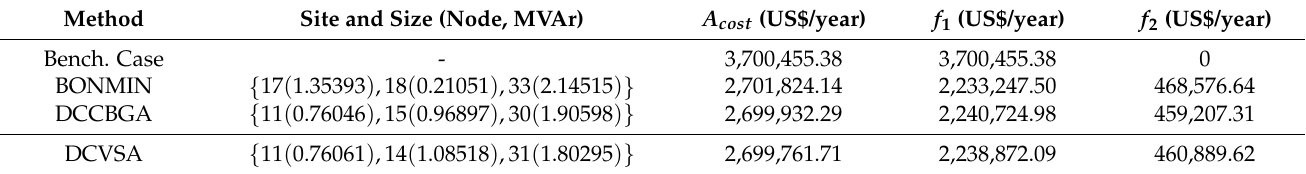
Table 2. Numerical results in the AC version of the IEEE 33-bus